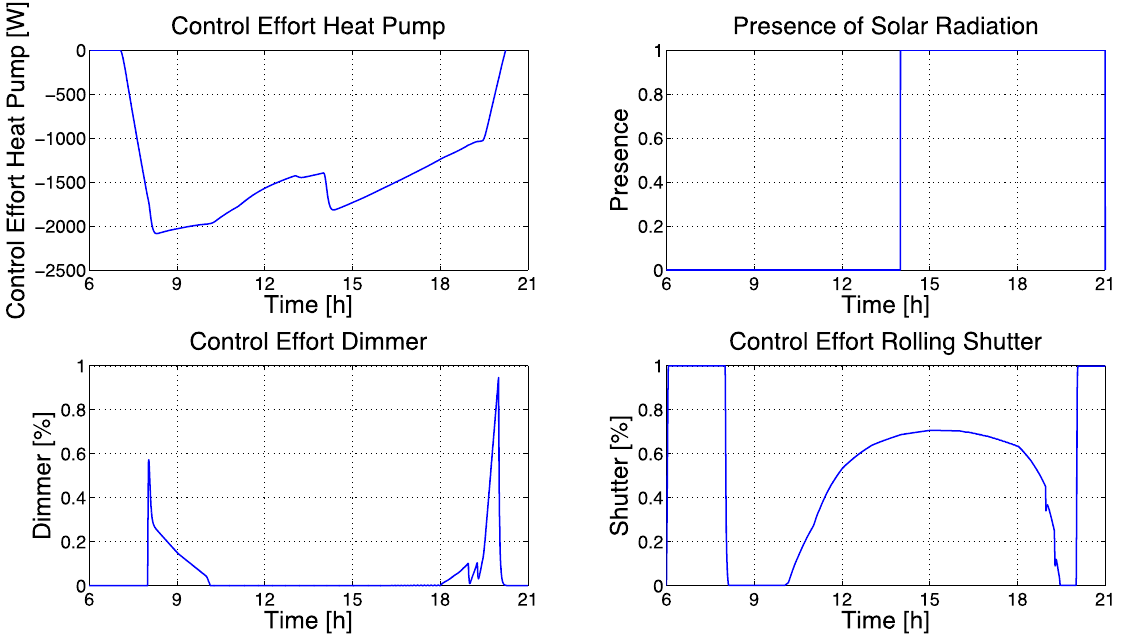
Figure 37. Control results (third scenario, modified control system, Comfort policy): room illumi- nance (CV).